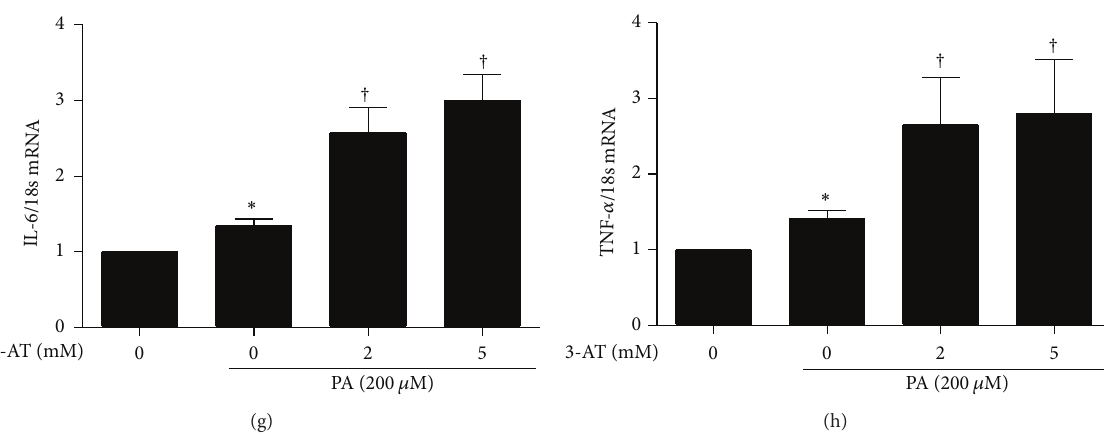
Figure 5: Catalase inhibition accelerates inflammation in RAW264.7 macrophages. RAW264.7 cells were treated for 6 h with 0, 1, 2, 5, and 10mM 3-AT. (a) JNK phosphorylation was quantified by western blot (upper panel) and densitometry (lower panel). (b) IL-1 𝛽 , (c) IL-6, and (d) TNF- 𝛼 mRNA levels were measured by real-time PCR. (e) JNK phosphorylation was also determined by western blot (upper panel) and densitometry (lower panel) in cells treated with 0, 1, 2, 5, and 10 mM 3-AT 1 h prior to stimulation with 200 𝜇 M PA for 6h. (f) IL-1 𝛽 , (g) IL-6, and (h) TNF- 𝛼 mRNA levels were also measured by real-time PCR in these cells. Data are mean ± SE of four experiments. BSA was used as control for the effects of PA. ∗ 𝑝 < 0.05 versus control; † 𝑝 < 0.05 versus